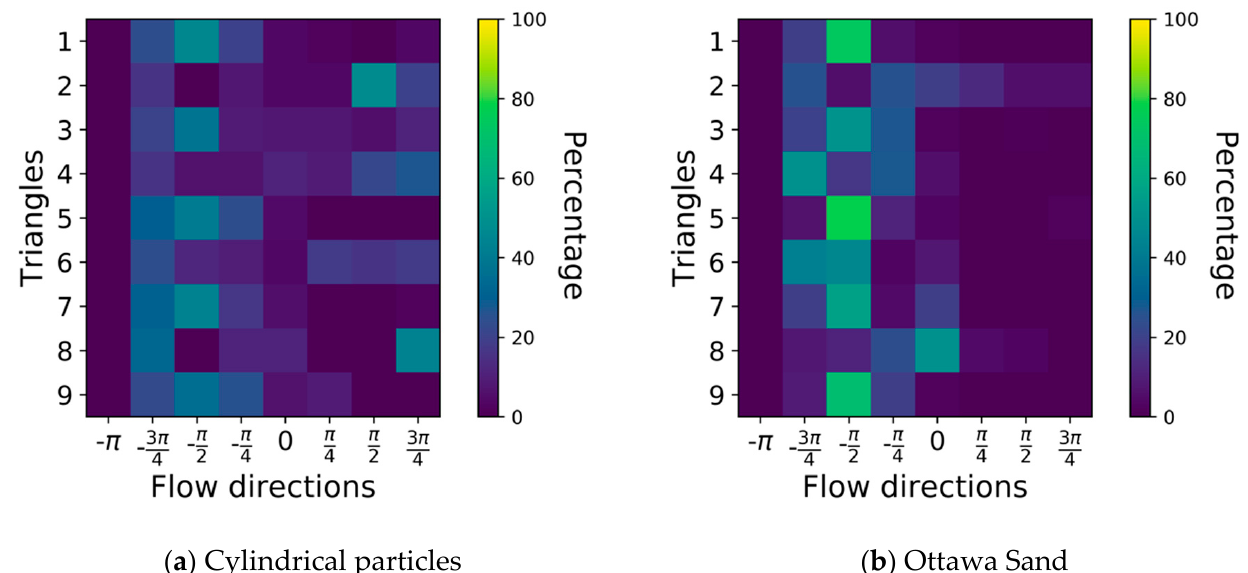
Figure 15. Comparison of the orientation of flow trajectories between ( a ) cylindrical particles and ( b ) simulated Ottawa sand particles.